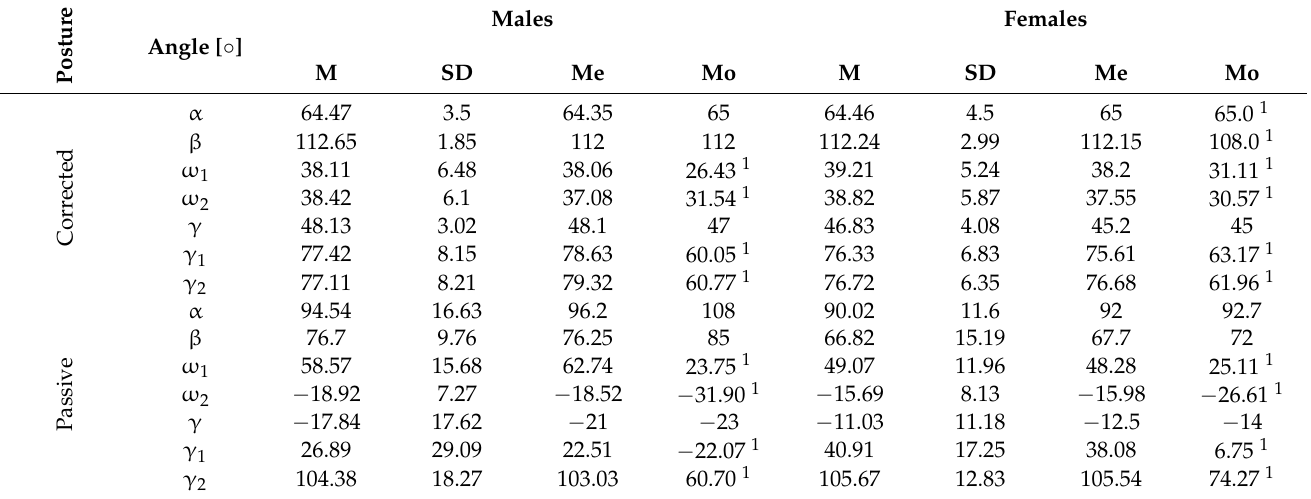
Table 1. Basic computational statistics results.